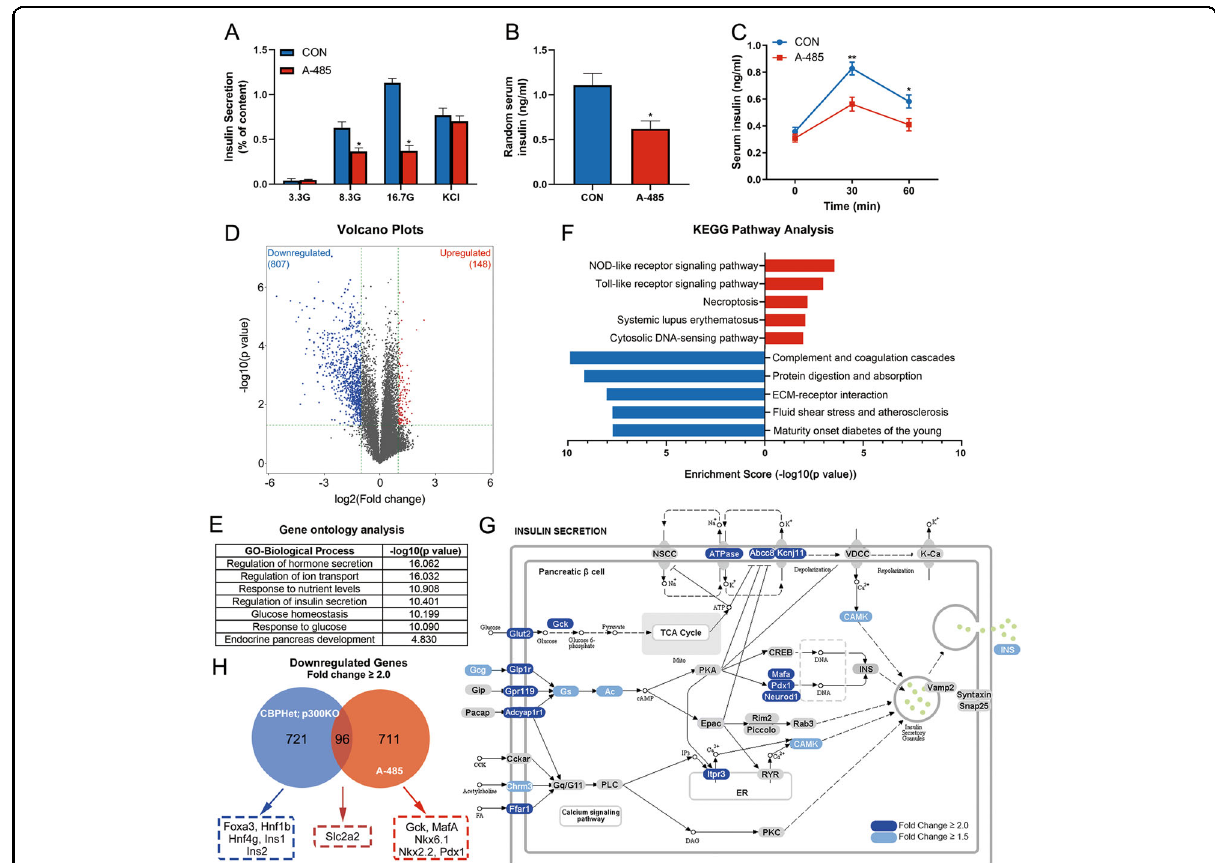
Fig. 1 Effects of A-485 on insulin secretion and transcriptome pro fi le of rat islets. A Isolated rat islets were pretreated with 3 μ M A-485 at 5.6 mM glucose for 16 h, followed by stimulation with 3.3, 8.3 and 16.7 mM glucose or 35 mM KCl for 1 h, and insulin secretion was measured. B Random serum insulin levels of control and A-485-treated C57BL/6 mice ( n = 5). C Serum insulin levels under glucose loading in control and A-485- treated C57BL/6 mice ( n = 5). D Volcano plots of differentially expressed genes. E Top 5 upregulated (red) and downregulated (blue) pathways in KEGG analysis. F GO analysis of downregulated genes. G Visualization of downregulated genes involved in insulin secretion pathway. Dark blue represents fold change ≥ 2.0 and light blue represents fold change ≥ 1.5. Gray-labeled genes show no signi fi cant change. H Overlap analysis of downregulated genes between CBP/p300 HAT-inhibited rat islets and pancreatic endocrine progenitors-speci fi c CBP Het ; p300 KO mice islets (fold change ≥ 2.0, p -value <0.05). Data are given as mean ± SD for three separate experiments. * p < 0.05, ** p < 0.01 vs control (CON)